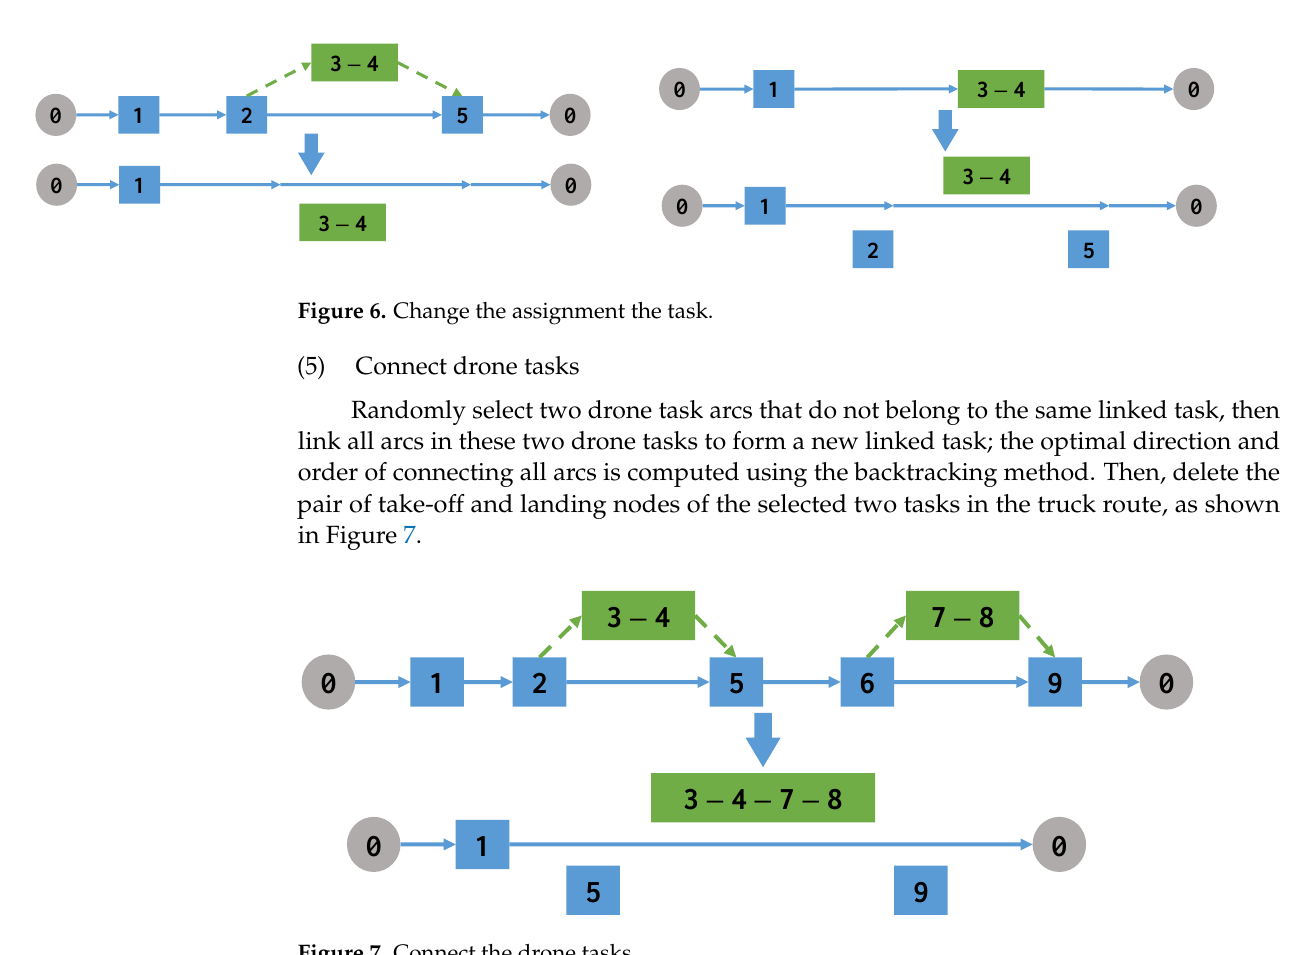
043 Figure 4. Change the takeoff and landing points of the task. (3) Update the truck route Randomly select a task, if it is a task performed by a drone, delete the take-off and landing nodes of the drone task from the truck route; if it is a task performed by the truck, directly delete the two endpoints of the task from the truck route, as shown in Figure 5. 0